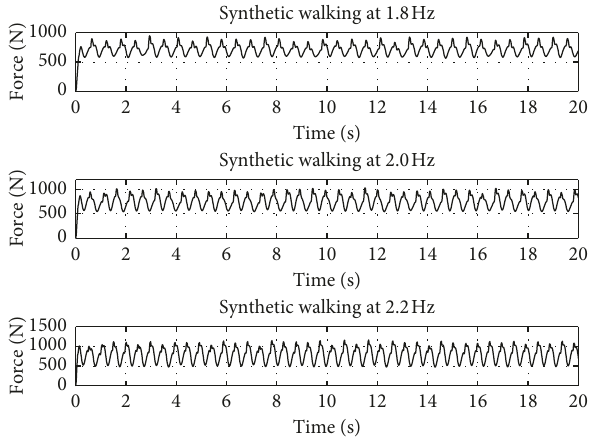
Synthetic walking at 1.8Hz